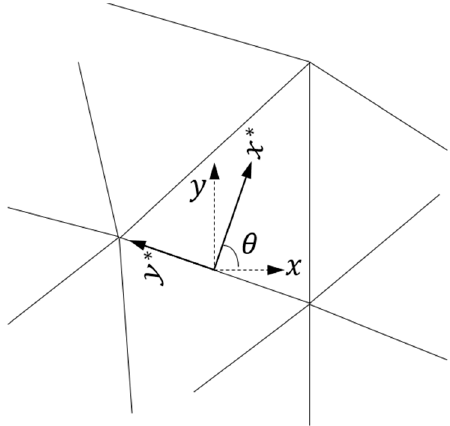
Figure 3. Introduction of a new coordinate system, where 𝑥 and 𝑦 are the axes of the true east and north coordinate; 𝑥 ∗ and 𝑦 ∗ are the transformed axes assigned at each side; and 𝜃 is the angle between these two axes.